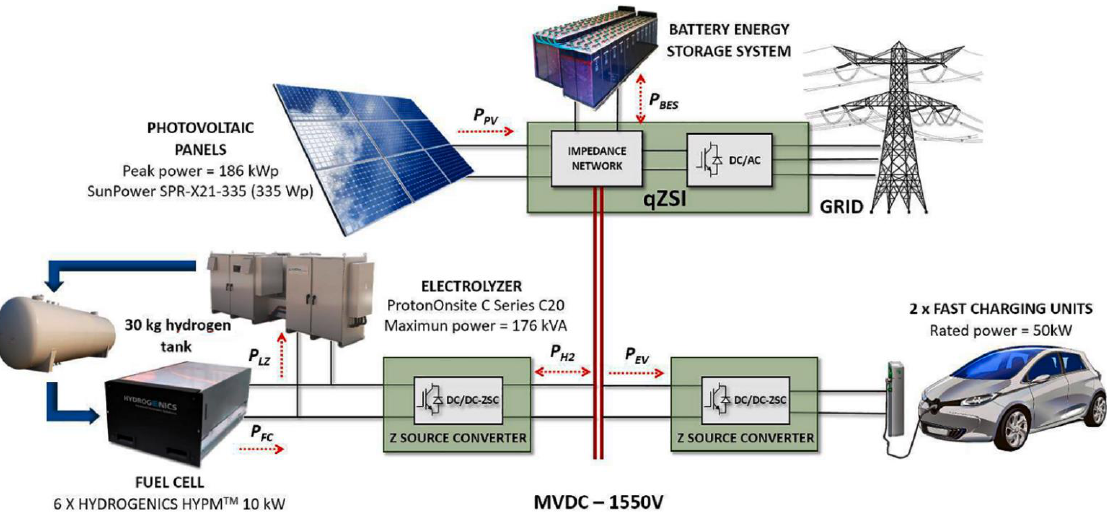
Figure 10. Schematic representation of a microgrid that includes an energy management system with a biogeography-based optimization algorithm to control the energy flow between the components. Reprinted with permission from Ref. [50]. 2021, Elsevier. Table 2. Control strategies for hybrid PV-RHFC microgrid systems.